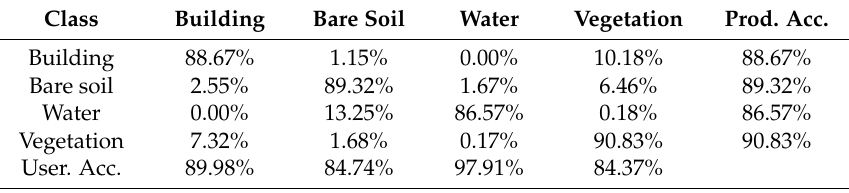
Table 3. Confusion matric of the proposed classification